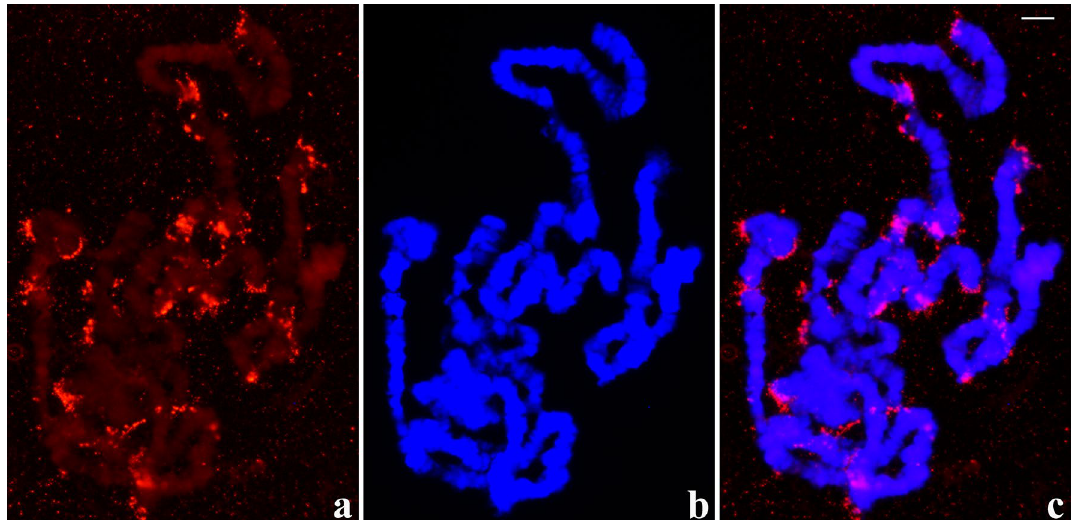
Figure 2. ( a–c ) Localisation of the rDNA in Schwenkfeldina sp. polytene chromosomes of the salivary gland showing significant rDNA dispersion as visualised by RNA probe signals ( a ), its corresponding DAPI staining image ( b ) and the merged signals ( c ) either disconnected or attached to the chromosomes. Bar = 45